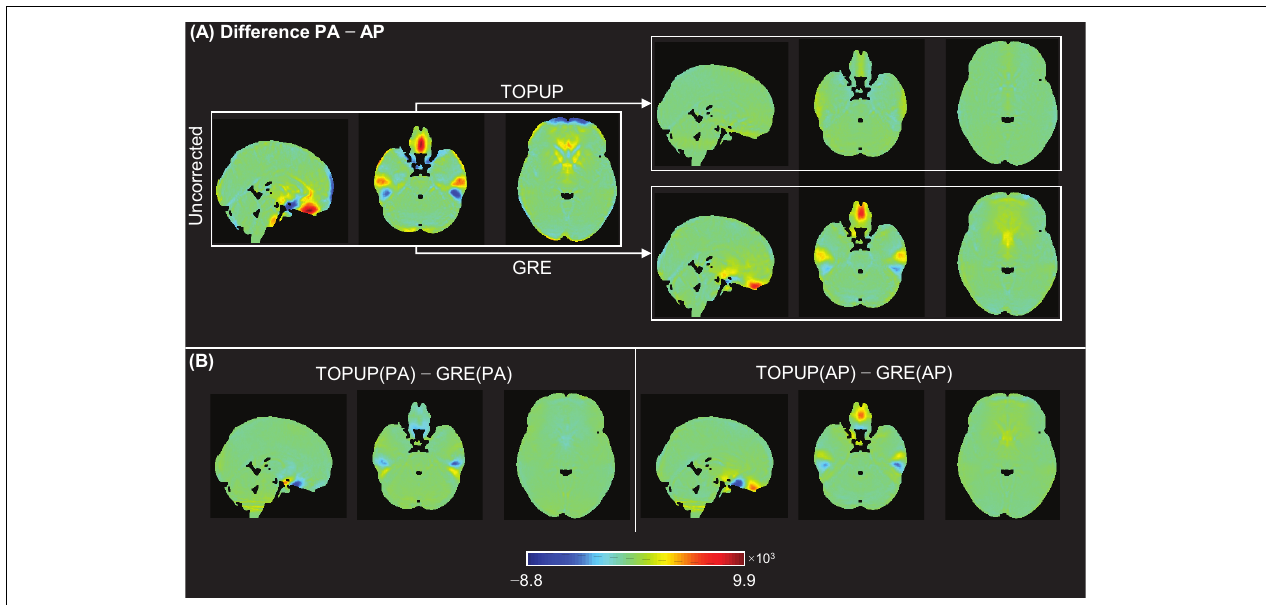
FIGURE 4 | (A) Voxel-wise difference maps between PA and AP images for the uncorrected case (left), and after correcting the data for the distortions using TOPUP (top-right) and GRE (bottom-right). (B) Voxel-wise difference maps of the corrected PA images (left) and corrected AP images (right), between correction methods. TABLE 2 | Differences between the PA and AP images without and with distortion correction using TOPUP and GRE, quantified in terms of nMSE and cross-correlation, averaged across participants (and voxels, in the case of the nMSE), and across runs. nMSE ± std Cross-correlation ± std Uncorrected TOPUP GRE Uncorrected TOPUP GRE Localizer